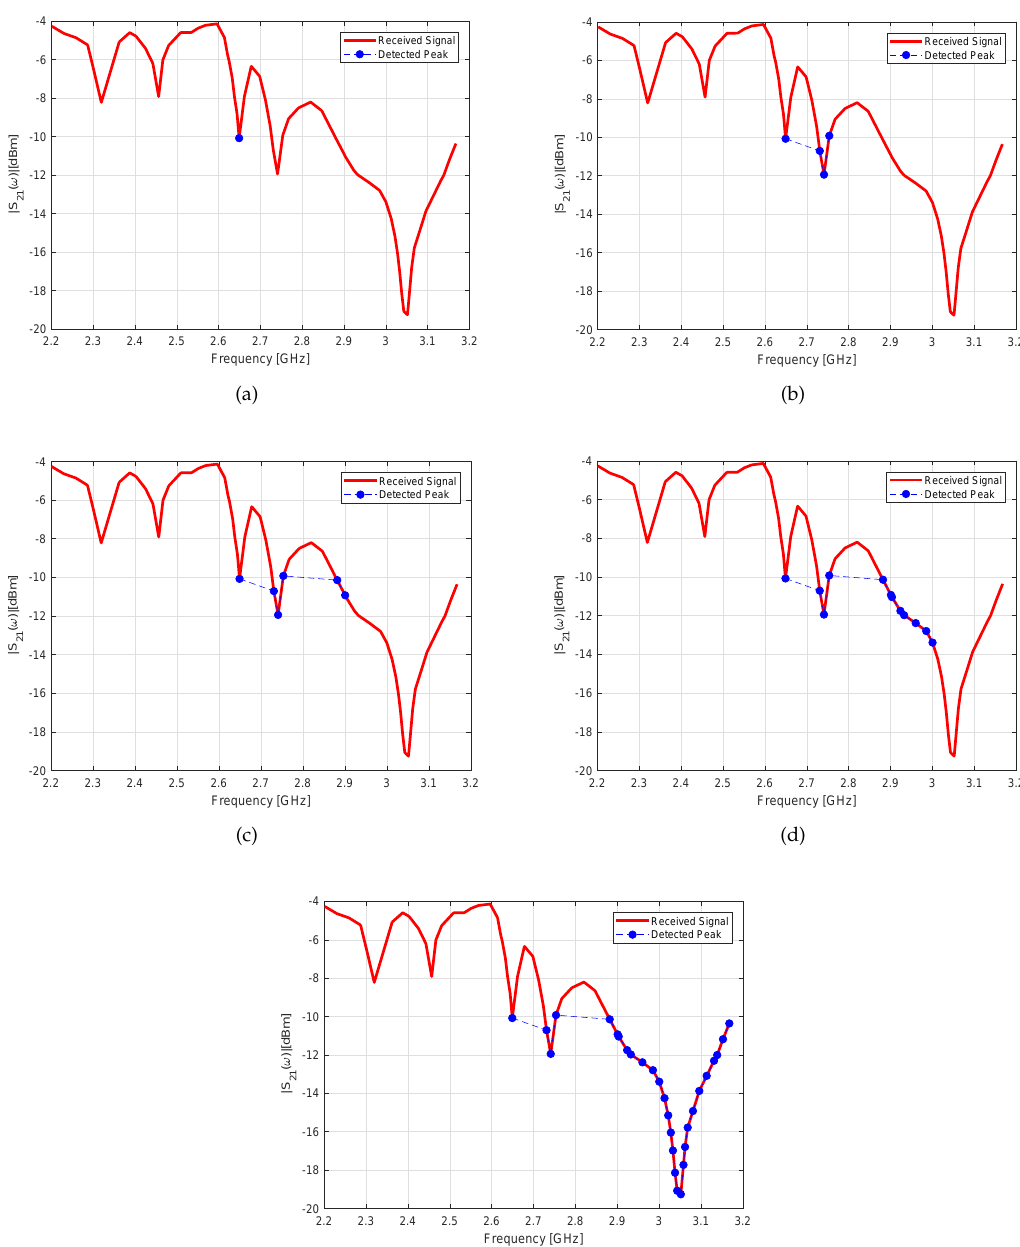
Figure 12. Peak detection for the received real-time signal with the tag configuration of 11111 using the newly proposed method. ( a ) step 1, ( b ) step 2, ( c ) step 3,( d ) step 4, and ( e ) final